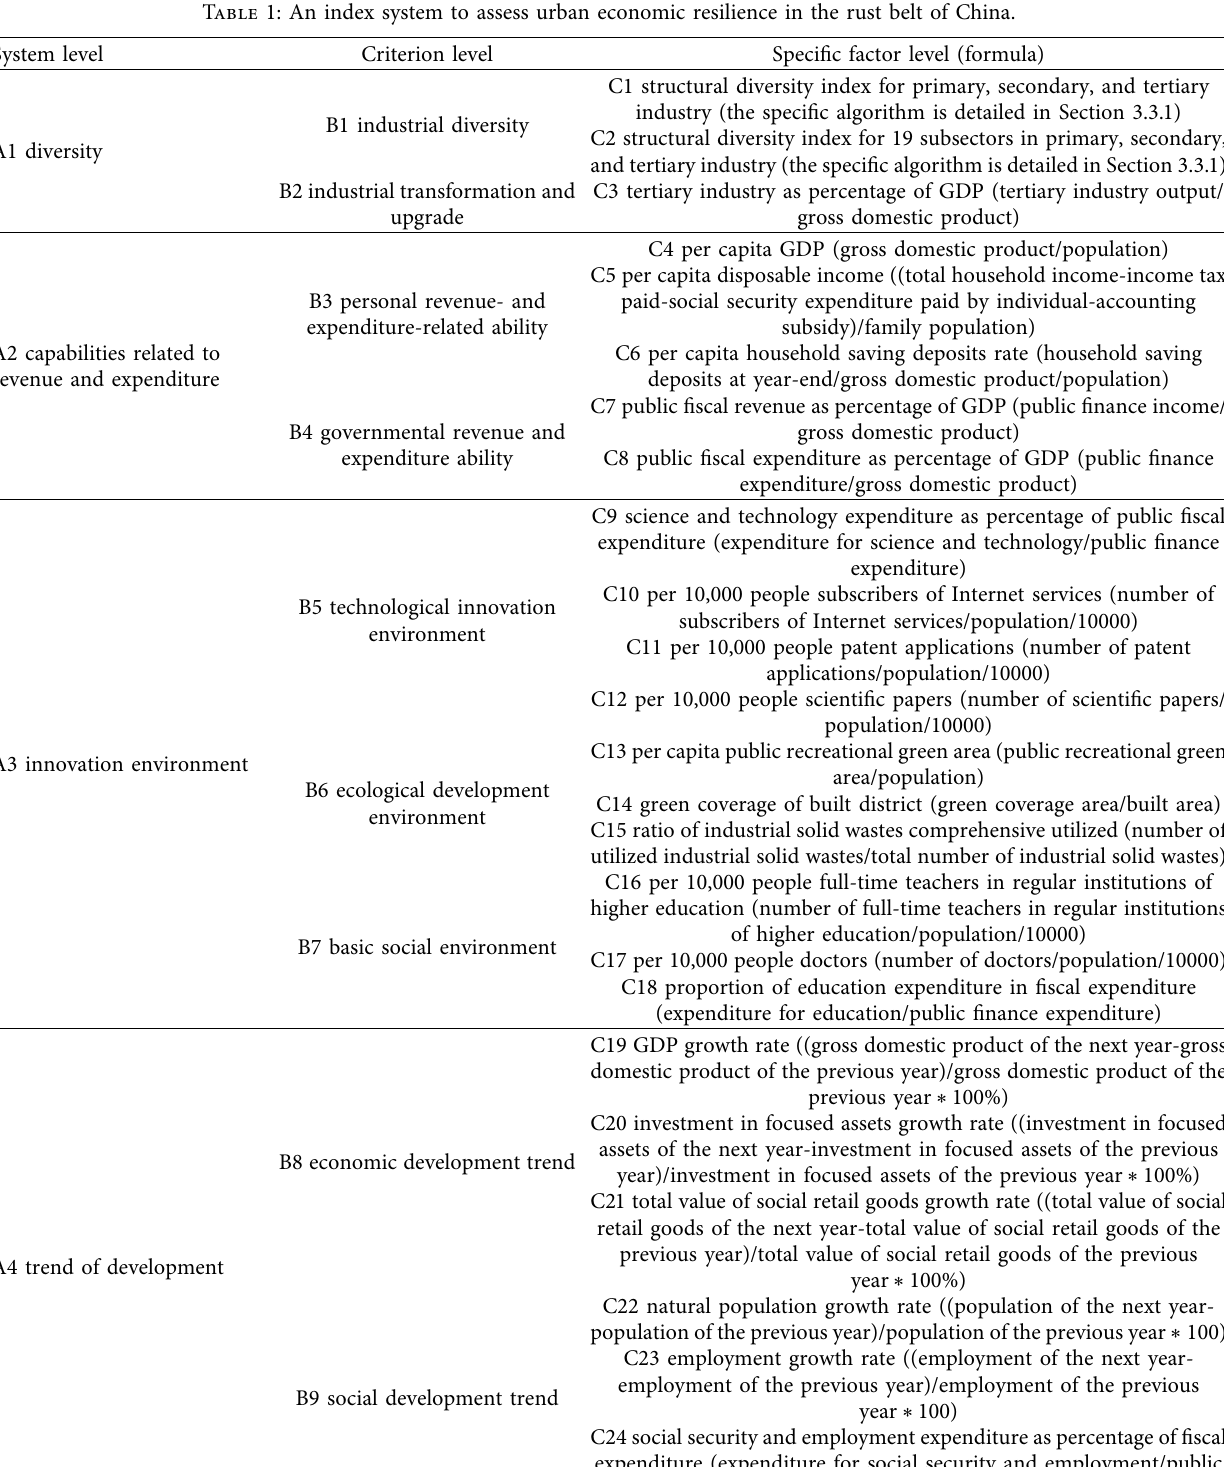
Table 1: An index system to assess urban economic resilience in the rust belt of